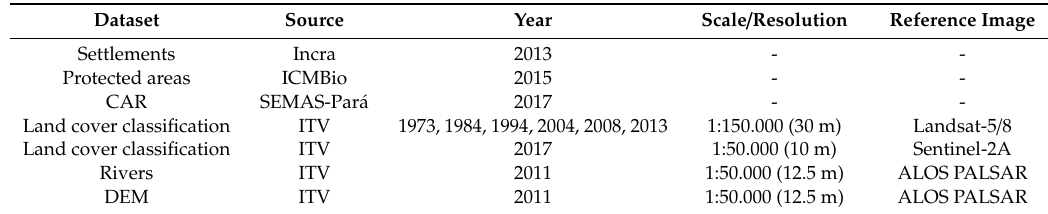
Table 1. Datasets used in this study. CAR— Environmental Rural Property Registry; digital elevation model—DEM; Incra— National Institute for Colonization and Agrarian Reform; ICMBio— Brazilian Institute for Biodiversity Conservation; SEMAS— State Secretariat of Environment and Sustainability; ITV— Instituto Tecnológico Vale.